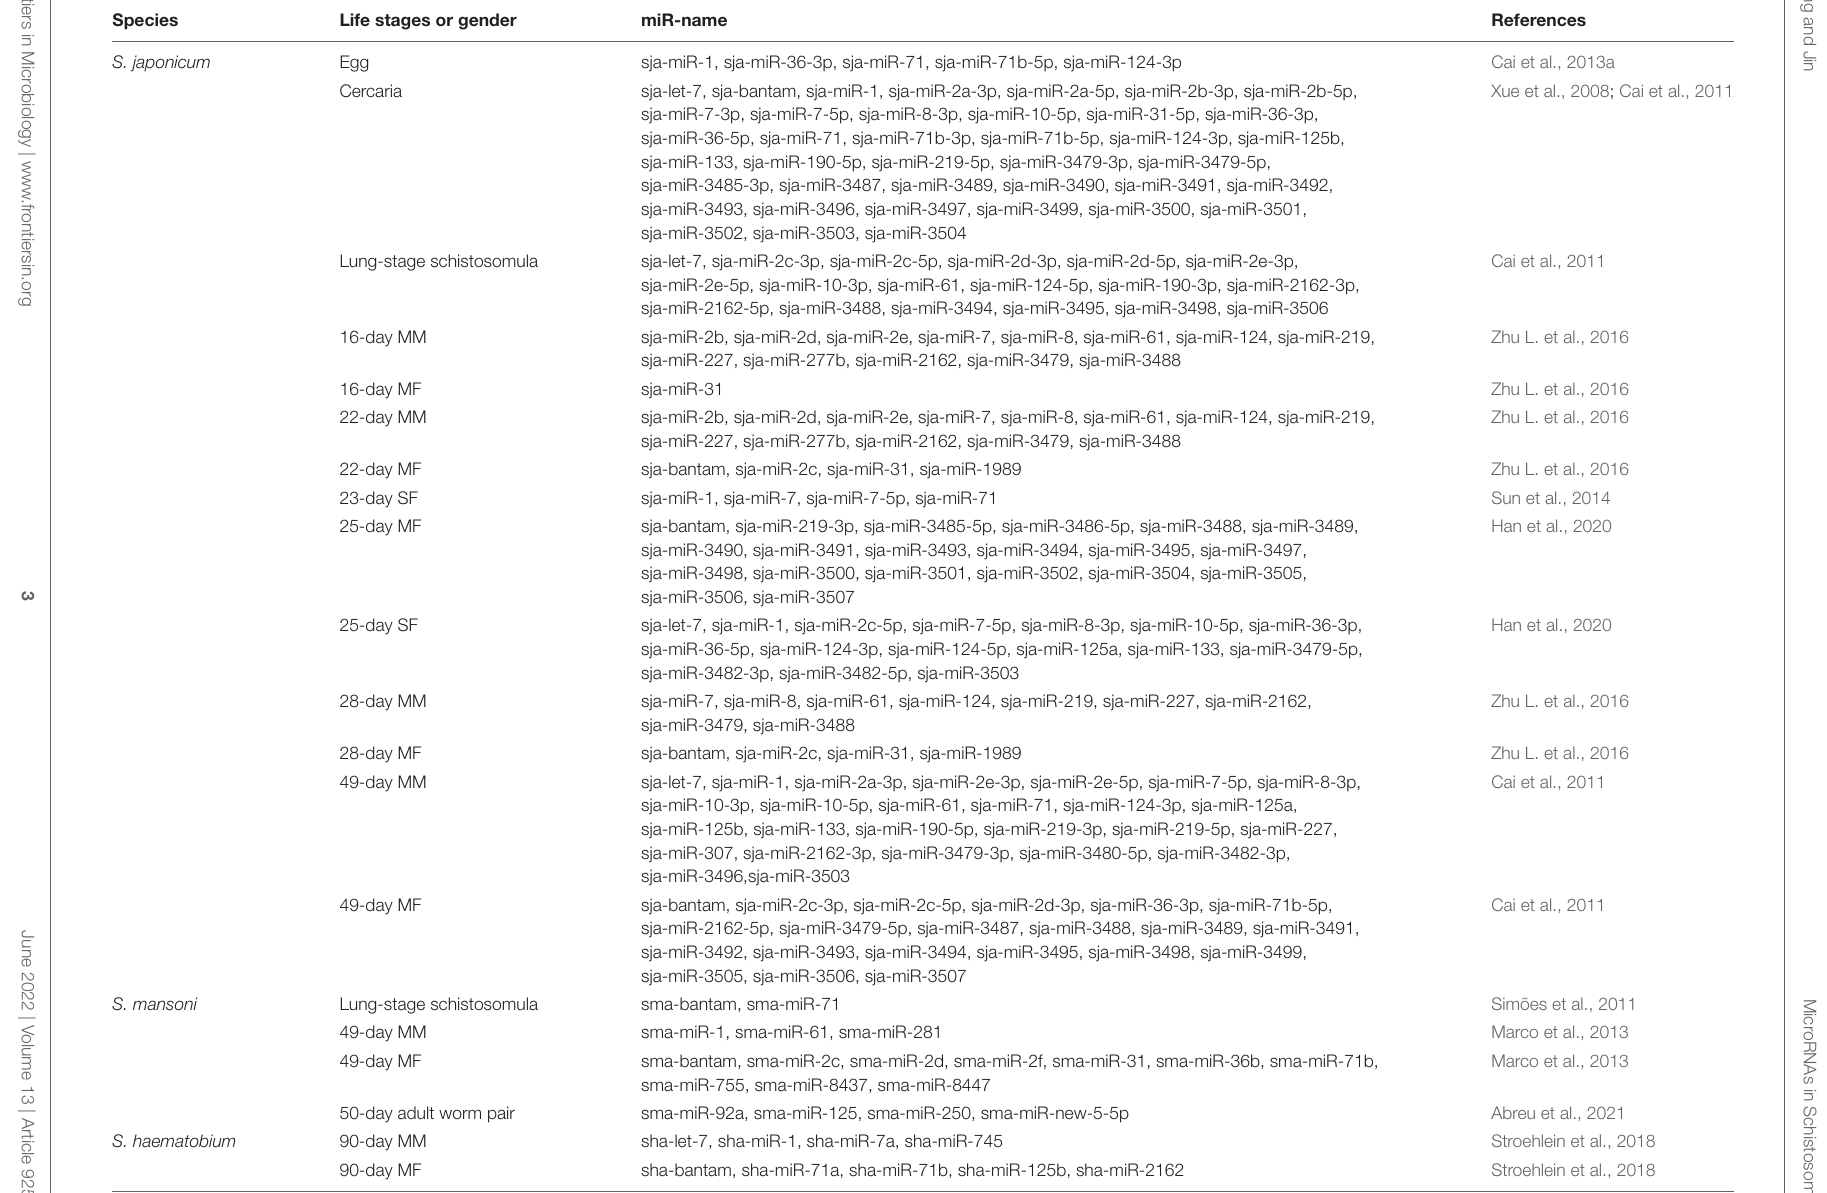
TABLE 1 | Summary of miRNAs upregulated in the different developmental stages or sexes of schistosome.